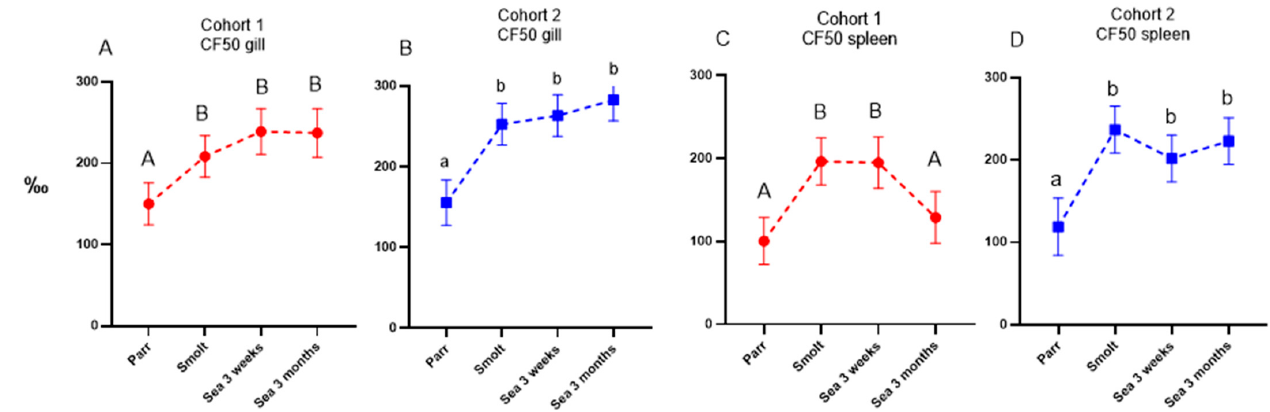
Figure 6. Sequencing of IgM variable region (Ig-seq). Cumulative frequencies (‰) of fifty largest clonotypes (CF50) in gill ( A , B ) and spleen ( C , D ). Data are presented as mean + SEM (n = 6–7). Data points within one cohort not sharing the same letters are significantly different (ANOVA, LSD test, p < 0.05).